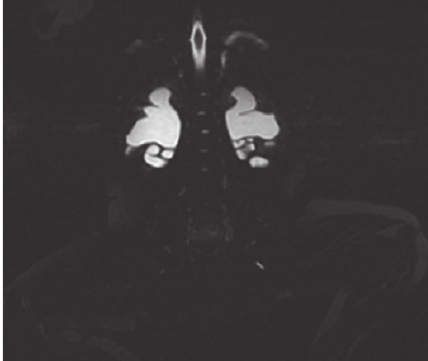
Figure 3: MRI showed bilateral pelvicalyceal dilation and tortuous